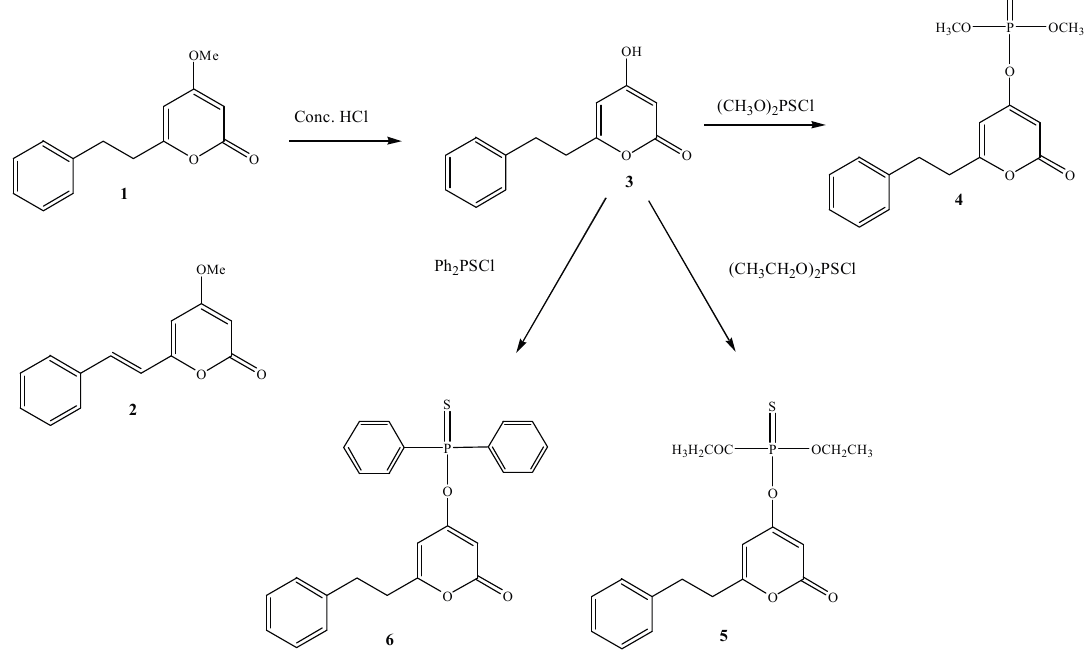
Scheme 2. Structures and synthesis route of DDK derivatives [15]. 1 : DDK; 2 : DK; 3 :